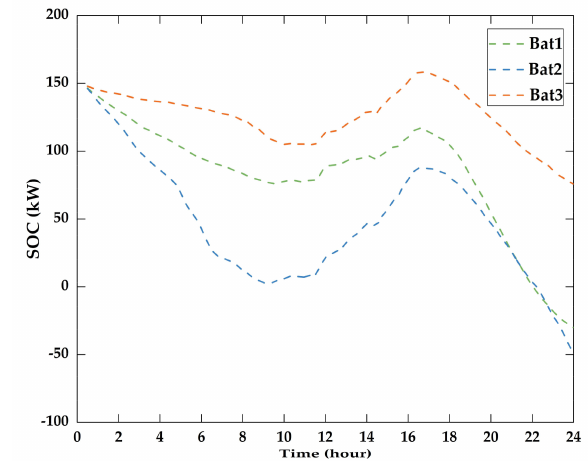
Figure 16. SOCs of batteries when modules run independently.